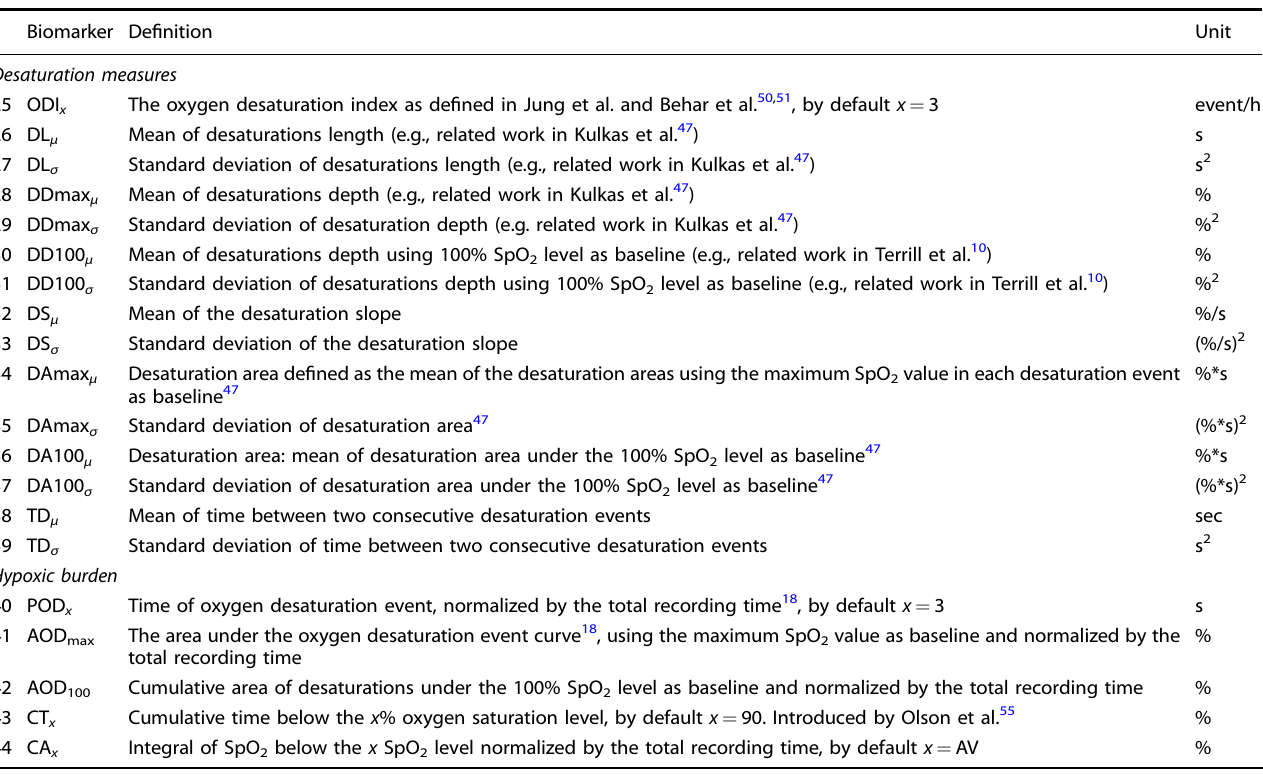
Table 4. List of digital oximetry biomarkers for the categories: desaturation measures and hypoxic burden. Biomarker De fi nition Unit Desaturation